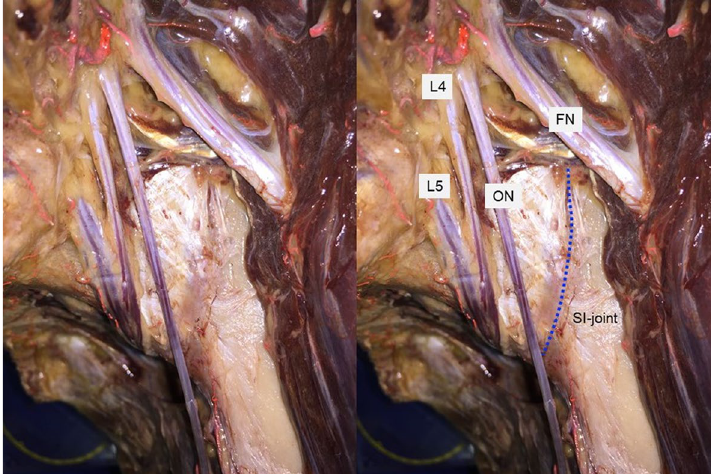
Figure 1. Dissected lumbosacral trunk in a left Thiel fixated hemipelvis with the additional part of the lumbar plexus ( FN femoral nerve, L4 ventral branch of fourth lumbar spinal nerve, L5 ventral branch of fifth lumbar spinal nerve, ON obturator